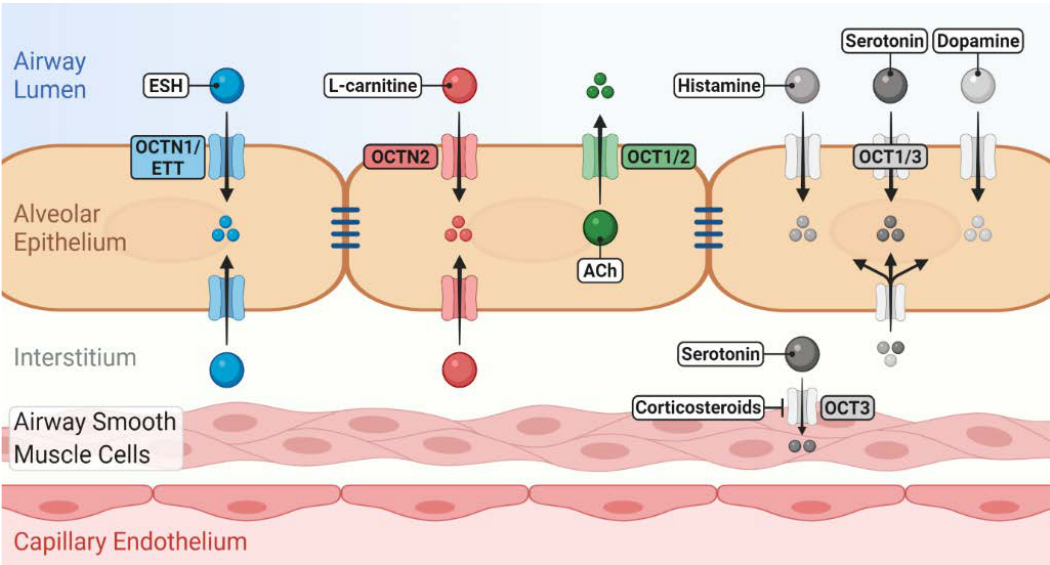
Figure 1. Role of novel/organic cation transporters (OCT/Ns) in pulmonary disposition of endogenous substrates. OCTN1/ergothioneine (ESH) transporter (ETT) mediates the uptake of ESH, which